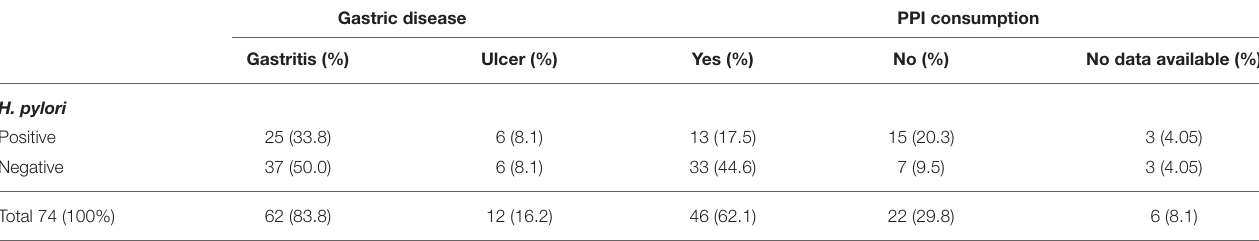
TABLE 1 | Classification of 74 yeast-positive patients according to gastric disease, the occurrence of H. pylori infection and PPI consumption.